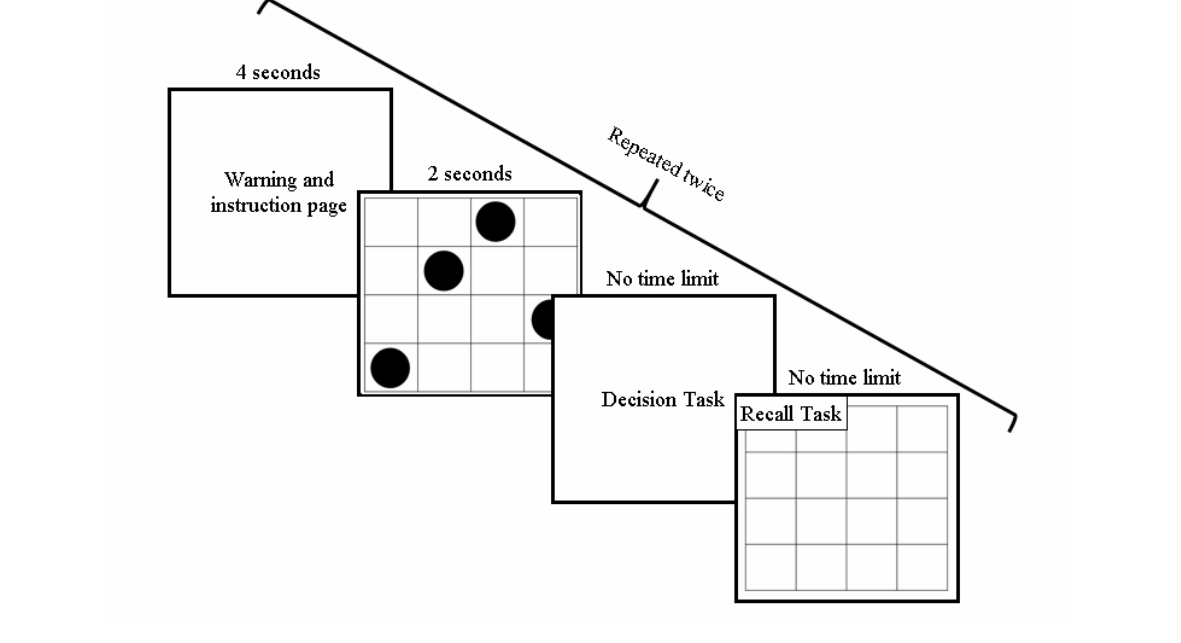
Figure 1. Flow of the decision phase. The first decision task consisted of the choice variable while the second decision task consisted of the attitude rating. The high cognitive load is displayed for illustrative purposes; the actual pattern depended on cognitive load